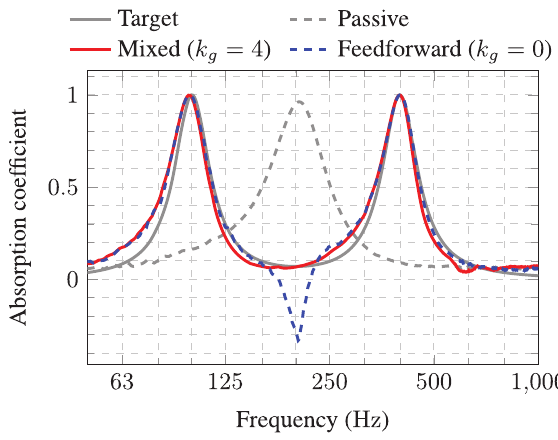
Figure 10. Experimentally obtained absorption coef fi cients for the two-degree-of-freedom absorber, with